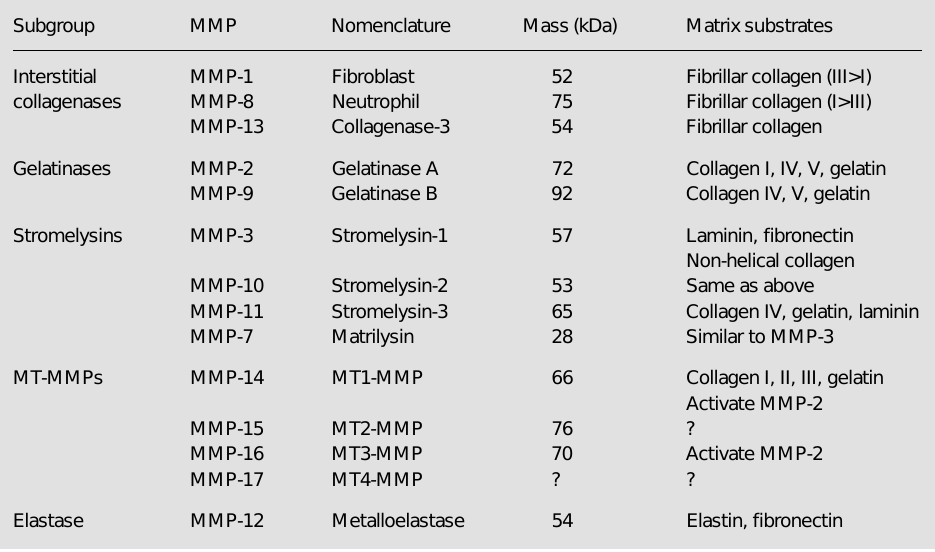
Table 1 - Classification of matrix metalloproteinases